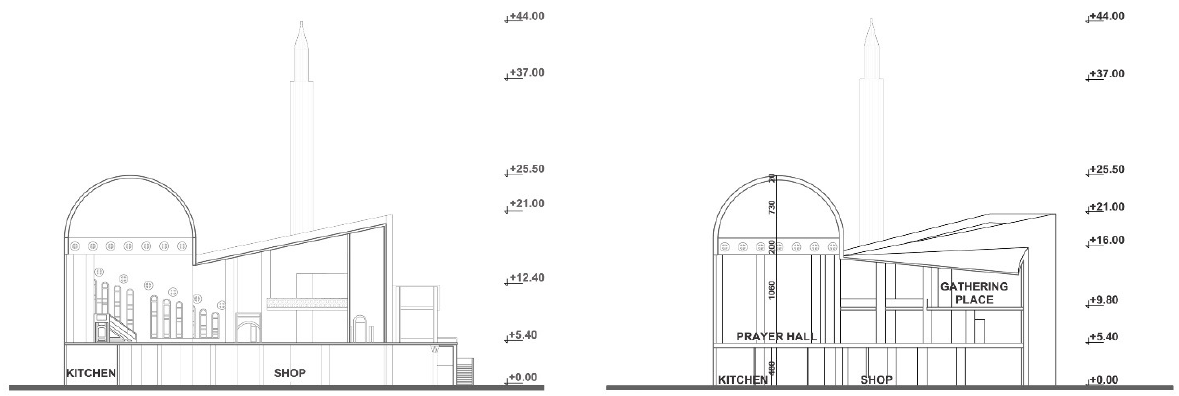
Figure 18. The Akdeniz Sanayi Mosque A-A and B-B sections .